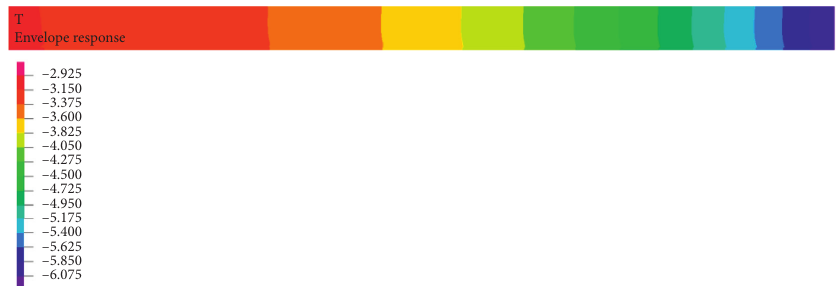
Figure 25: Annual average air temperature distribution in the tunnel axis at a depth of 20 m.